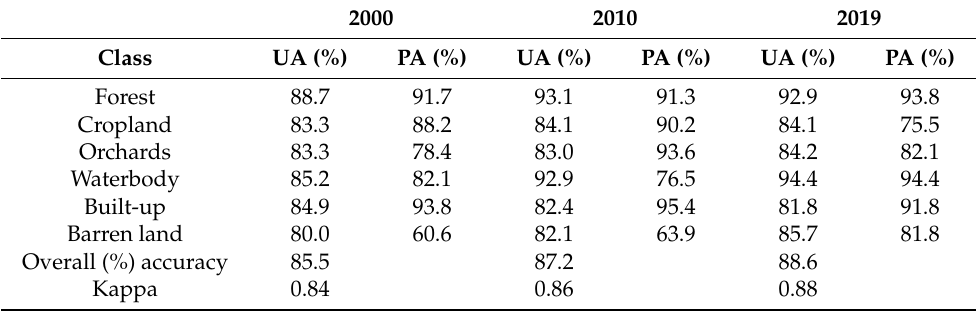
Table 4. Accuracy statistics of LULC maps produced from satellite imageries.